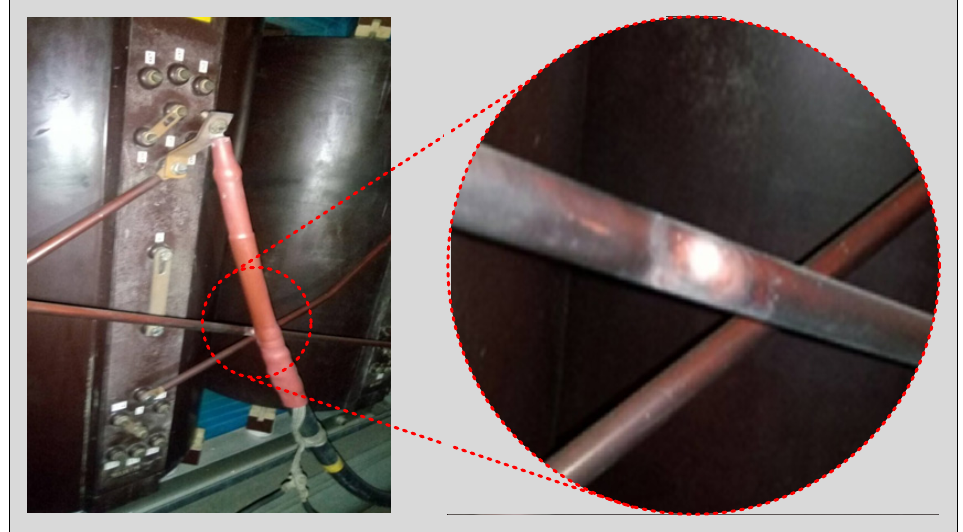
Figure 15. The evident of partial discharge on the insulator surface of high voltage